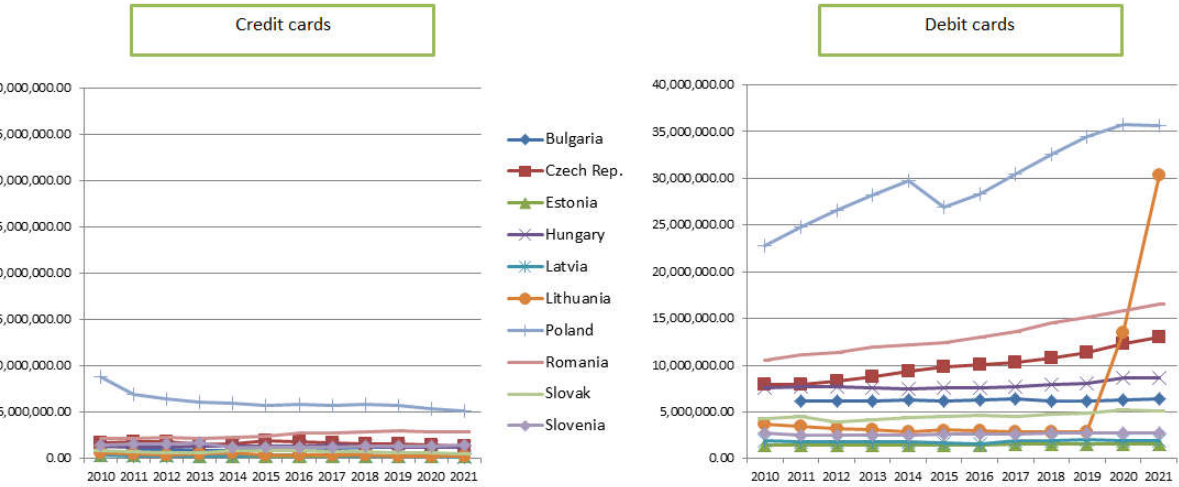
Figure 5. Evolution of credit cards (CC) and debit cards (DC).